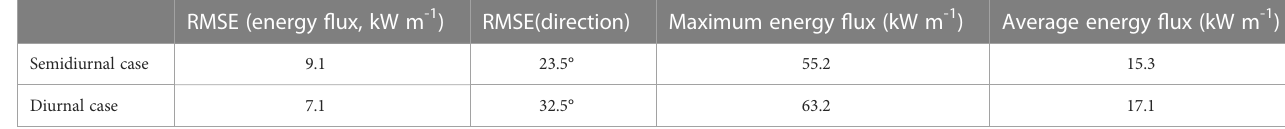
TABLE 2 The RMSEs between internal tide energy fl ux of the simulations and that of the estimate from in situ observations (Alford et al., 2011). RMSE (energy fl ux, kW m -1 ) RMSE(direction) Maximum energy fl ux (kW m -1 ) Average energy fl ux (kW m -1 ) Semidiurnal case 9.1 23.5° 55.2 15.3 Diurnal case 7.1 32.5° 63.2 17.1 Maximum energy fl ux: The maximum energy fl ux in the LS region (120°E-122.5°E, 19°N-21.5°N, Figures 4E, F). Average energy fl ux: The average energy fl ux in the LS